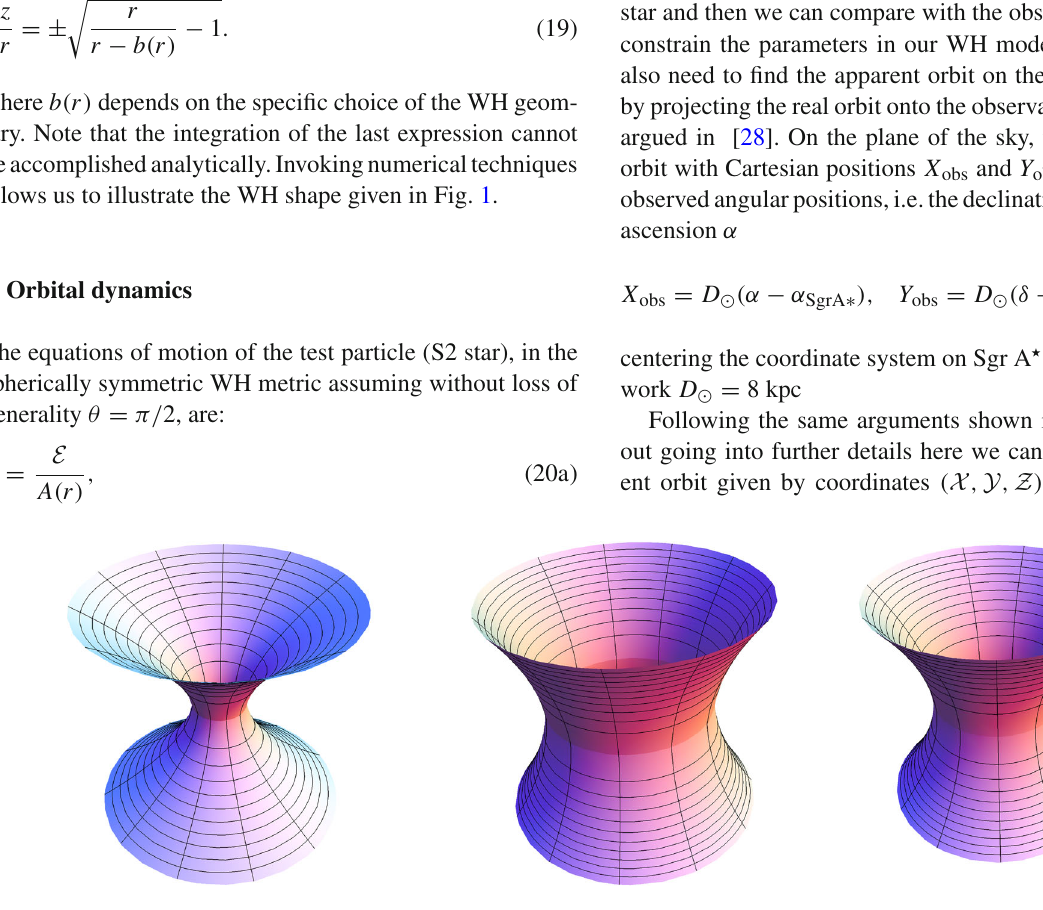
Fig. 1 Left to right: The embedding diagram of WH model I, WH model II and WH model III, respectively. We have used the constraint values for parameters obtained from